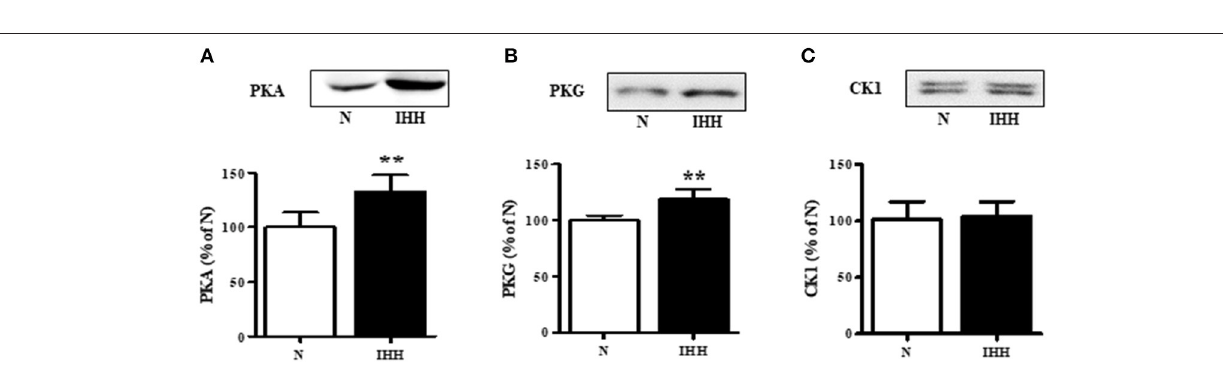
FIGURE 4 | Effect of chronic intermittent hypobaric hypoxia (IHH, black columns) on protein expression of Cx43 upstream protein kinases: protein kinase A (PKA) (A) , protein kinase G (PKG) (B) , and casein-kinase 1 (CK1) (C) assessed by western blotting in left ventricular myocardium. N, normoxic group (open columns). Values are mean ± SEM, ( n = 5 in each group), ** P <